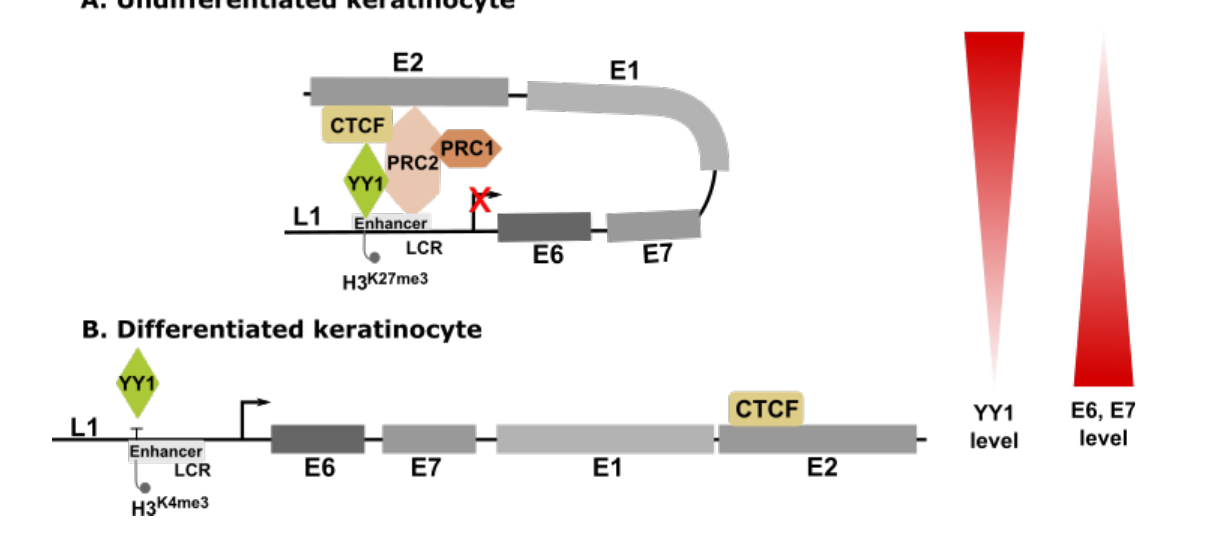
Figure 3. Model showing the role of YY1 during HPV life cycle in undifferentiated ( A ) and differentiated keratinocytes ( B ). The life cycle of HPVs is strongly associated with the differentiation program of the epithelial cells. HPV infection initiates in the undifferentiated basal epithelial cells where the expression of E6 and E7 genes is restricted by the establishment of a CTCF (CCCTC-binding factor)–YY1-dependent chromatin loop of epigenetically repressed chromatin ( A ). Upon epithelial differentiation, the production of early transcripts of virus is increased. In differentiated keratinocytes, the elevated E6 and E7 protein levels are important to maintain host cell proliferation and provide viral access to the host cell DNA replication machinery. This is synchronized with a differentiation-induced reduction in YY1 levels, which releases the repressive chromatin loop and attenuates the recruitment of polycomb repressor complexes (PRC1 and PRC2) and inhibits H3K27me3 (trimethylation of histone H3 at lysine 27) deposition. Increased accessibility and reduced H3K27Me3 at the viral enhancer sites result in derepression of the early promoter, increased RNA Pol II recruitment, and H3K4me3 (trimethylation of histone H3 at lysine 4) deposition, resulting in increased E6/E7 oncogene expression.